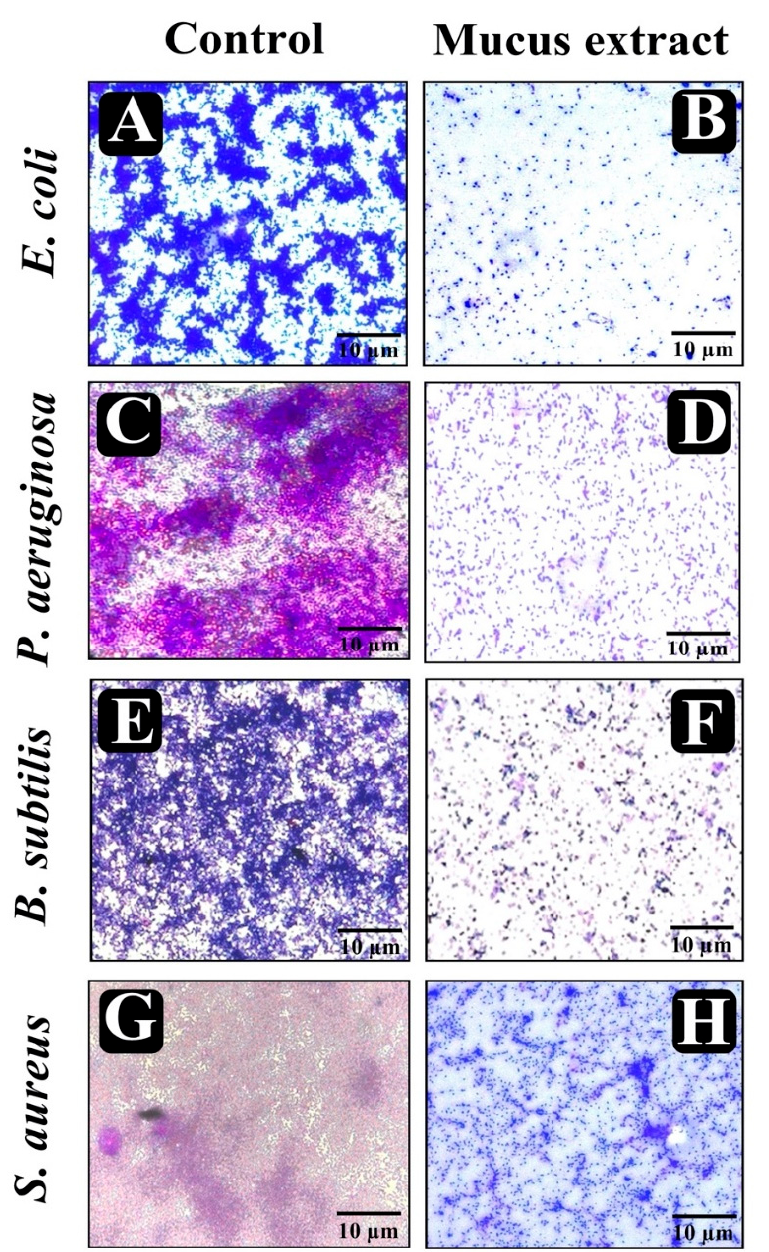
Figure 6. Micrographs of disrupted matured biofilms of tested strains formed on glass surfaces by P. sophore mucus extract at their respective MICs under light microscopy. ( A , C , E , G ) Growth control, ( B , D , F , H ) P. sophore mucus extract.